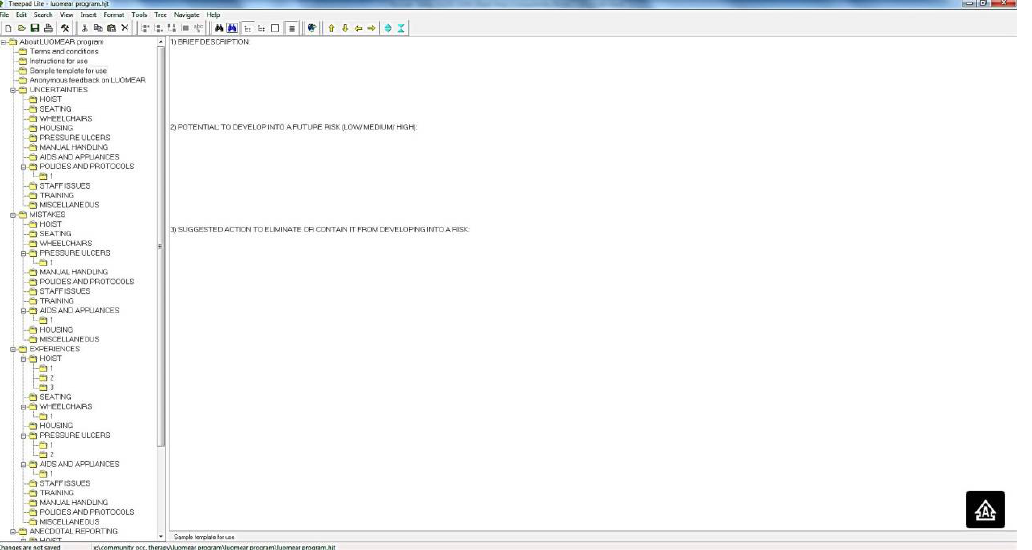
Figure 3. Screenshot of ’Sample template’ page in LUOMEAR program.